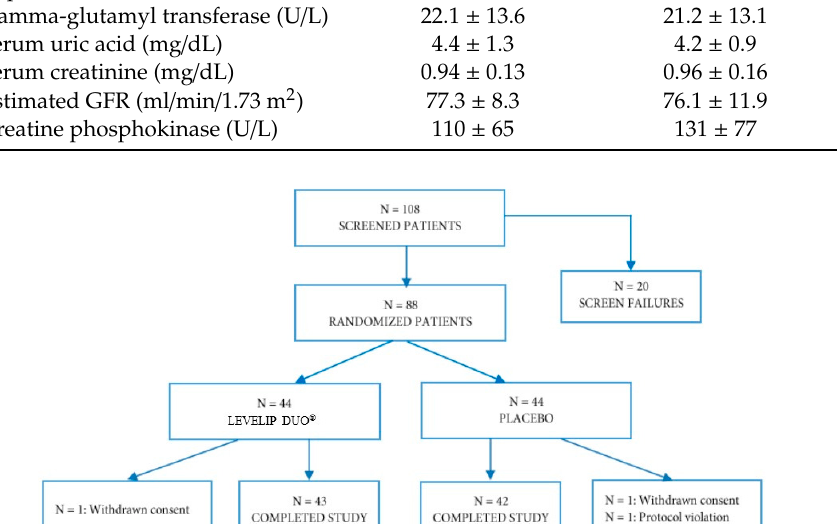
Figure 2. Patient Figure 2. Patient disposition.